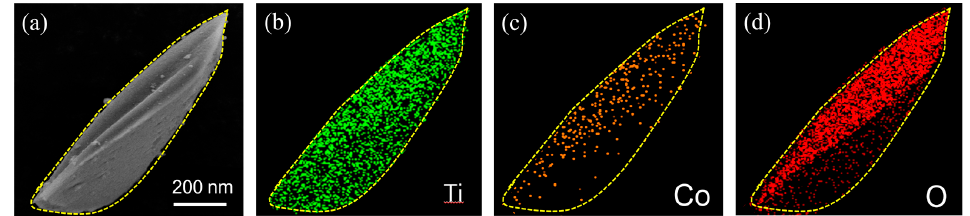
Figure 4. ( a ) SEM image of the Co@TiO 2 and the corresponding elemental mapping for ( b ) Ti, ( c ) Co, ( d ) O. Elemental distributions in Co@TiO 2 .